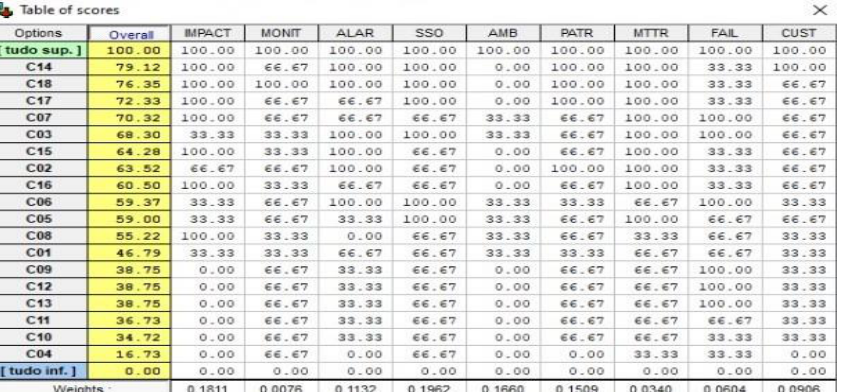
Figure 9. M-MACBETH window with results of multi-criteria model application on the boiler system, where power generation impact (IMPACT), monitoring level (MONIT), alarms and events priority (ALAR), occupational safety (SSO), environmental impact (AMB), patrimonial impact (PATR), medium time to repair (MTTR), failure recurrence (FAIL), and medium repair cost